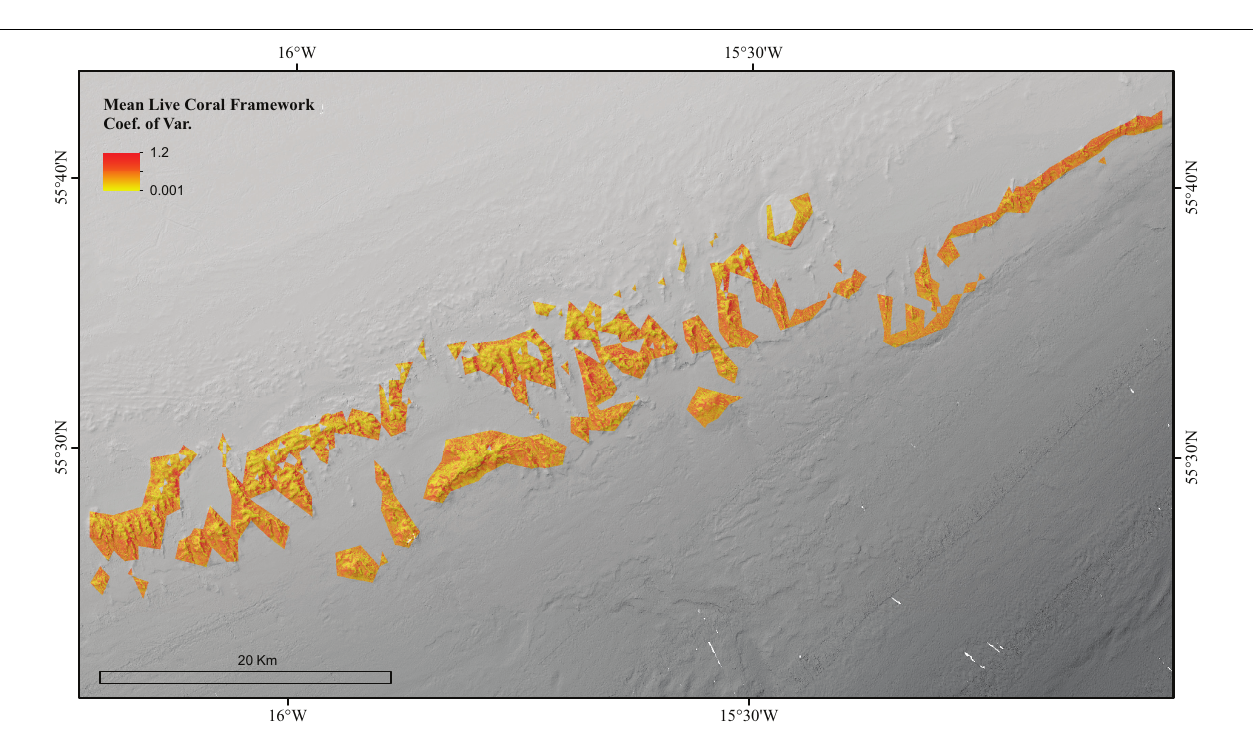
Mean Live Coral Framework Coef. of Var.